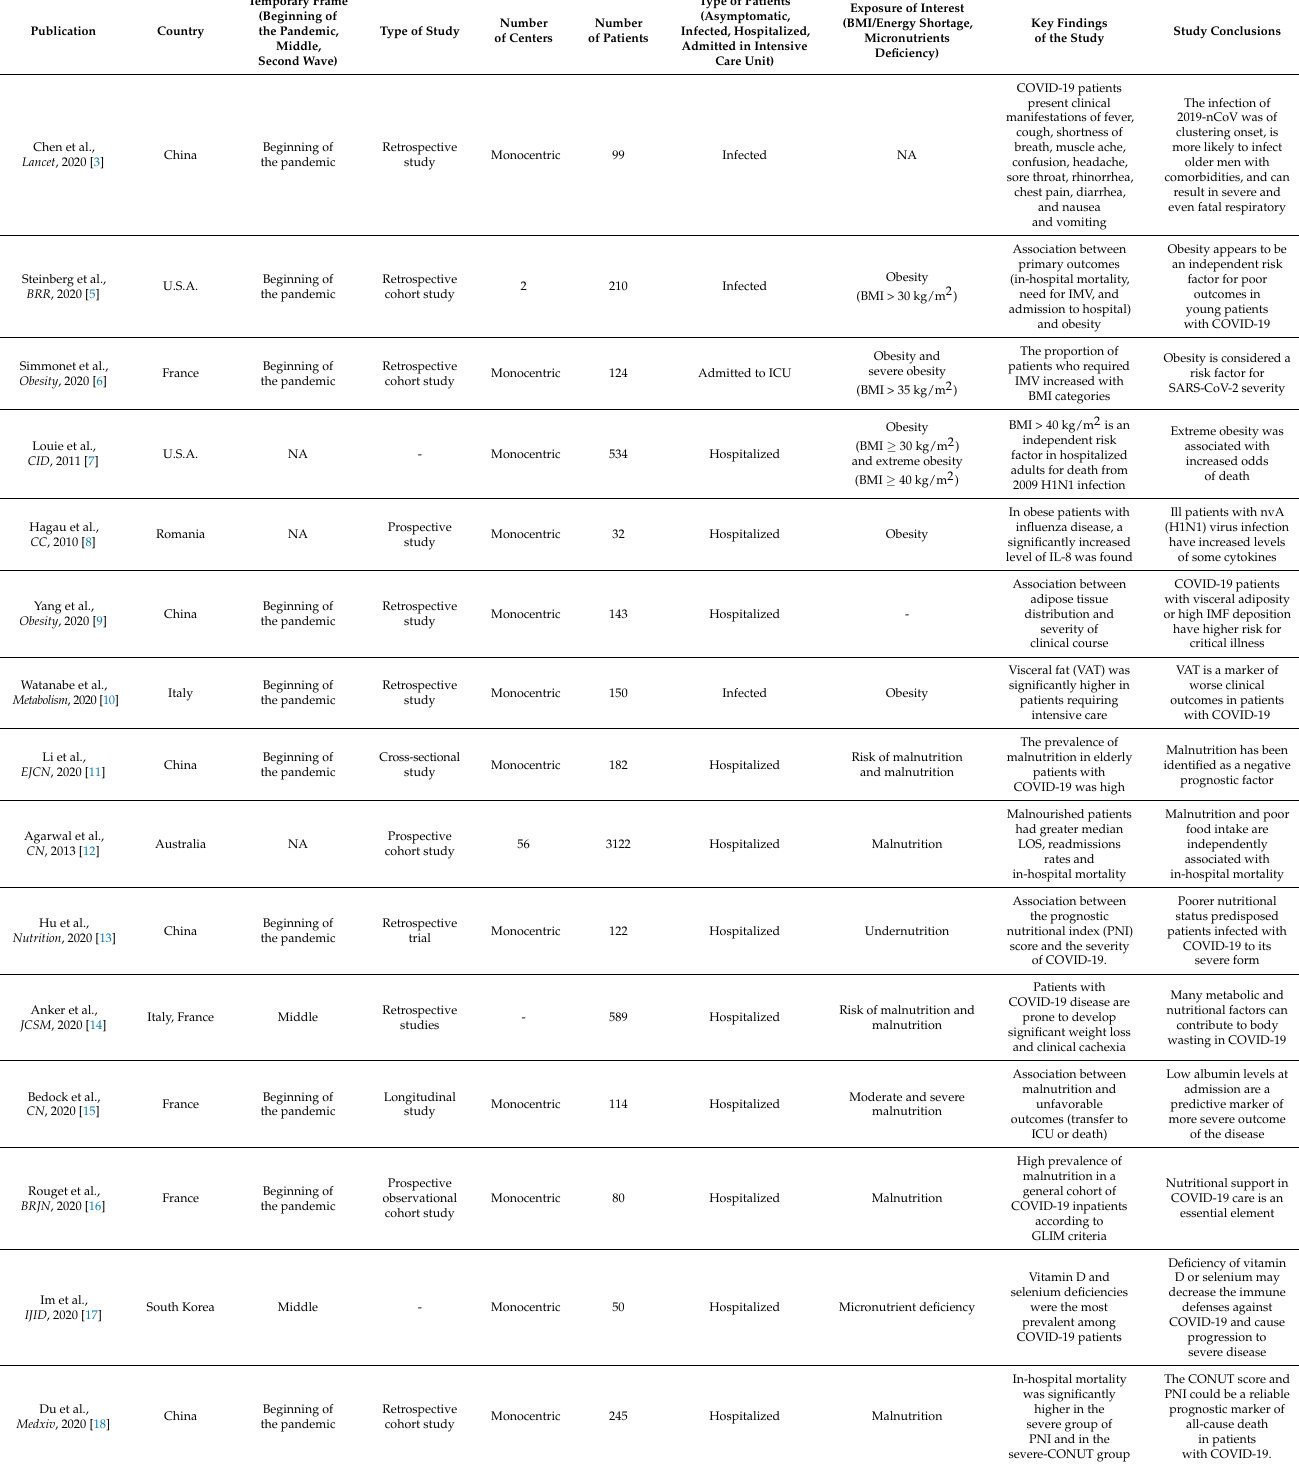
Table 1. Summary of the included